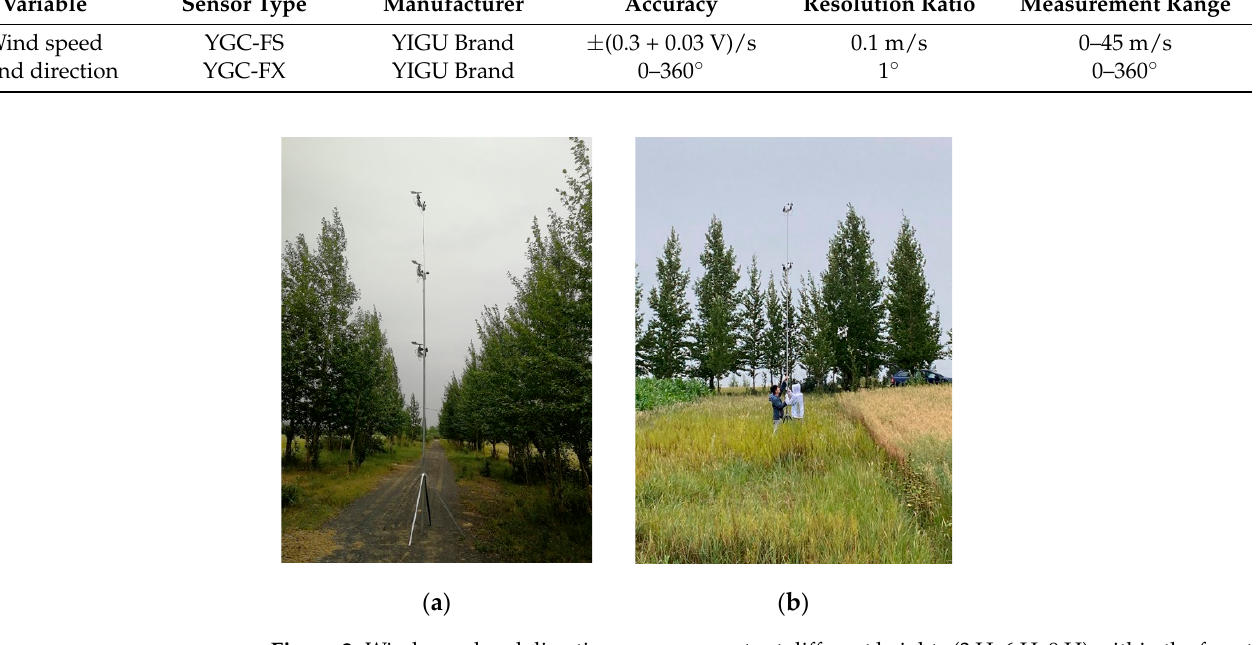
Figure 2. Wind speed and direction measurements at different heights (3 H, 6 H, 9 H) within the forest and behind the forest. ( a ) The instrument is placed in the middle of the woods. ( b ) the instrument is placed in front of the woods.